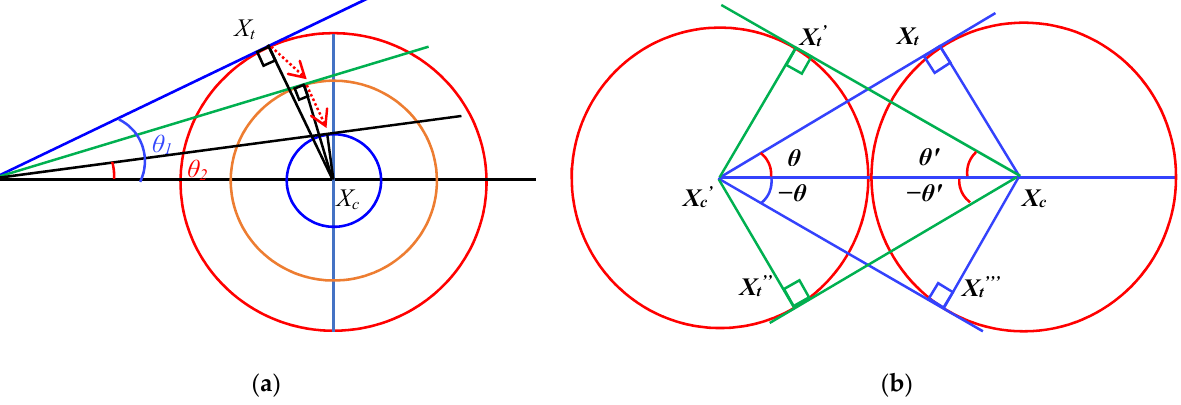
Figure 2. The processes of the CSA algorithm ( a ) exploitation; ( b ) exploration.